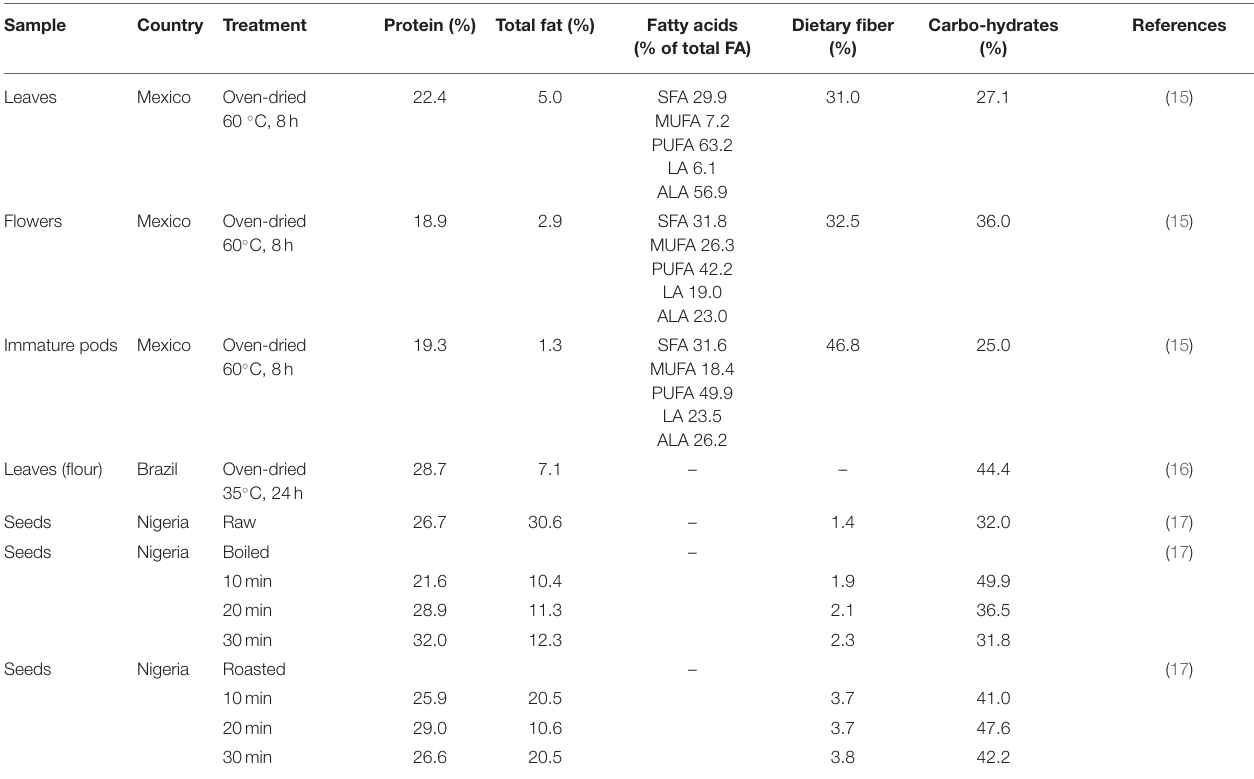
TABLE 1 | Macronutrient profile of Moringa oleifera leaves, flowers, immature pods and seeds a . Sample